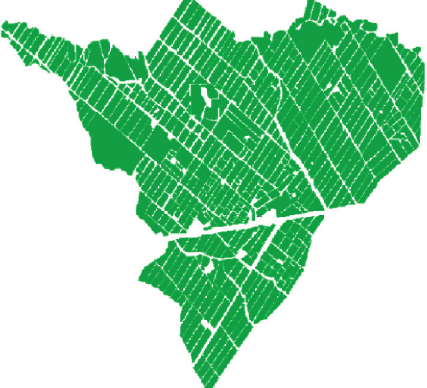
Figure 2: Division of R3 perimeter into 506 plots.